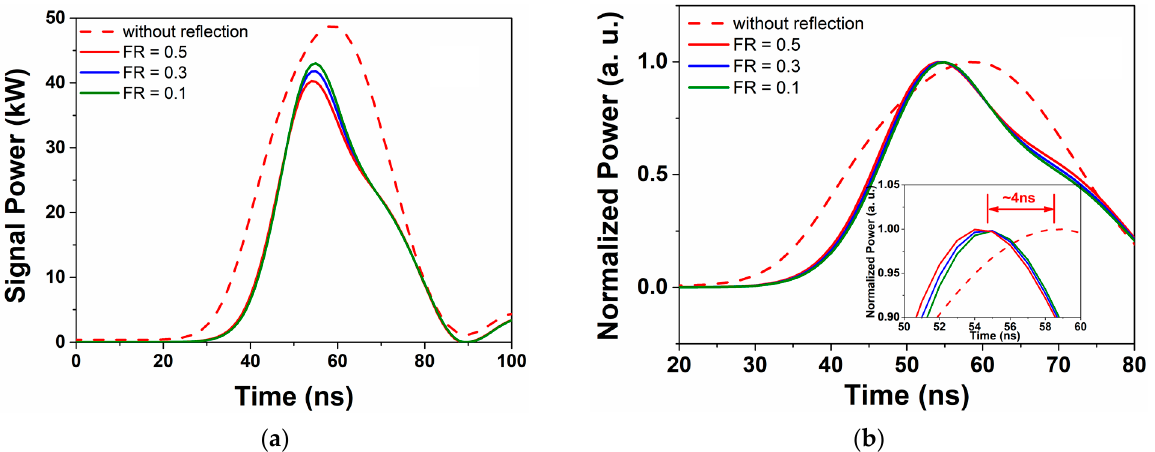
Figure 6. ( a ) The evolutions of the pulse waveforms with different FR. ( b ) The normalized pulse waveforms with different FR. The insertion is a magnification of the waveform near the pulse peak. Because of the influence of the PW feedback signal on the waveform and the gain, the position and peak power of the output will temporally jitter if there is a reflection on the fiber. The stability of the amplifier drastically decreases as a result of the vibration of the output pulse. Similarly, if the real working amplifier were to suffer an incident that caused extra reflections, such as fiber breakage, stress damage, or thermal fusion, this pulse instability would provide an optional path for amplifier stability diagnosis. According to the jitter of the output pulse, the damage from the accident could be reduced by dynamic adjustment of the seed laser, pump power, or heat dissipation conditions. This would help to improve the robustness and stability of the amplifier. In addition, the influence of the PW feedback signal on the temperature distribution of the gain fiber can be analyzed by using the CW feedback signal calculation method mentioned above. The temperature distribution can be calculated by converting the PW signal intensity into the average power of the CW signal. The conclusions obtained from the CW signal feedback also apply to the PW signal